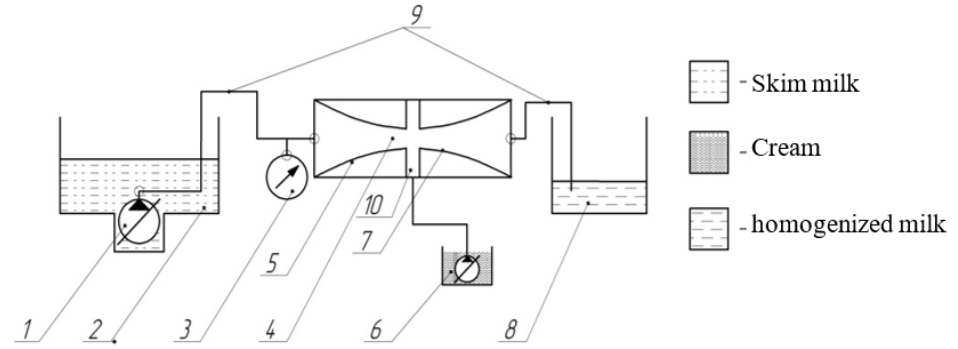
Figure 2. Technological scheme of the homogenizer for dispersing the fat phase of milk emulsion: 1—gear pump for supplying skim milk; 2—container for skim milk; 3—manometer; 4—place of greatest narrowing; 5—inner surfaces of the confusor; 6—gear pump for supplying cream; 7—inner surfaces of the diffuser; 8—container for draining the processed product; 9—flexible pipelines; and 10—ring slot for feeding the fatty phase.